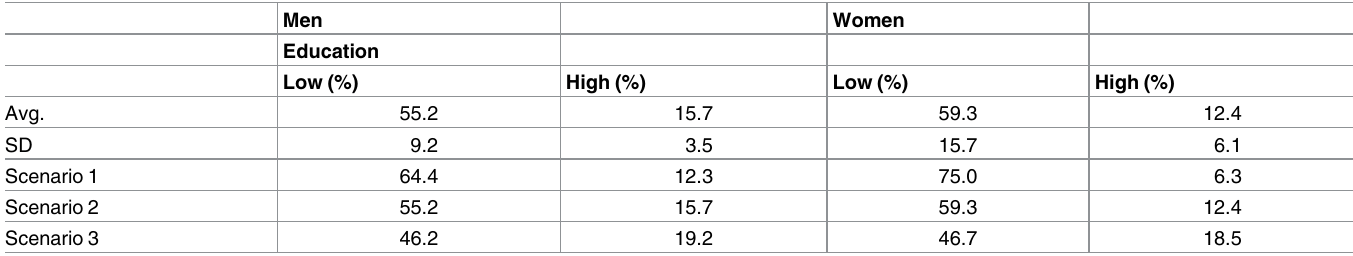
Table 2. Observed averageproportion and standard deviation of low and high educated in pooled data, definition of scenarios used to estimate educational inequalities mortality in different educational distributions, men and women.